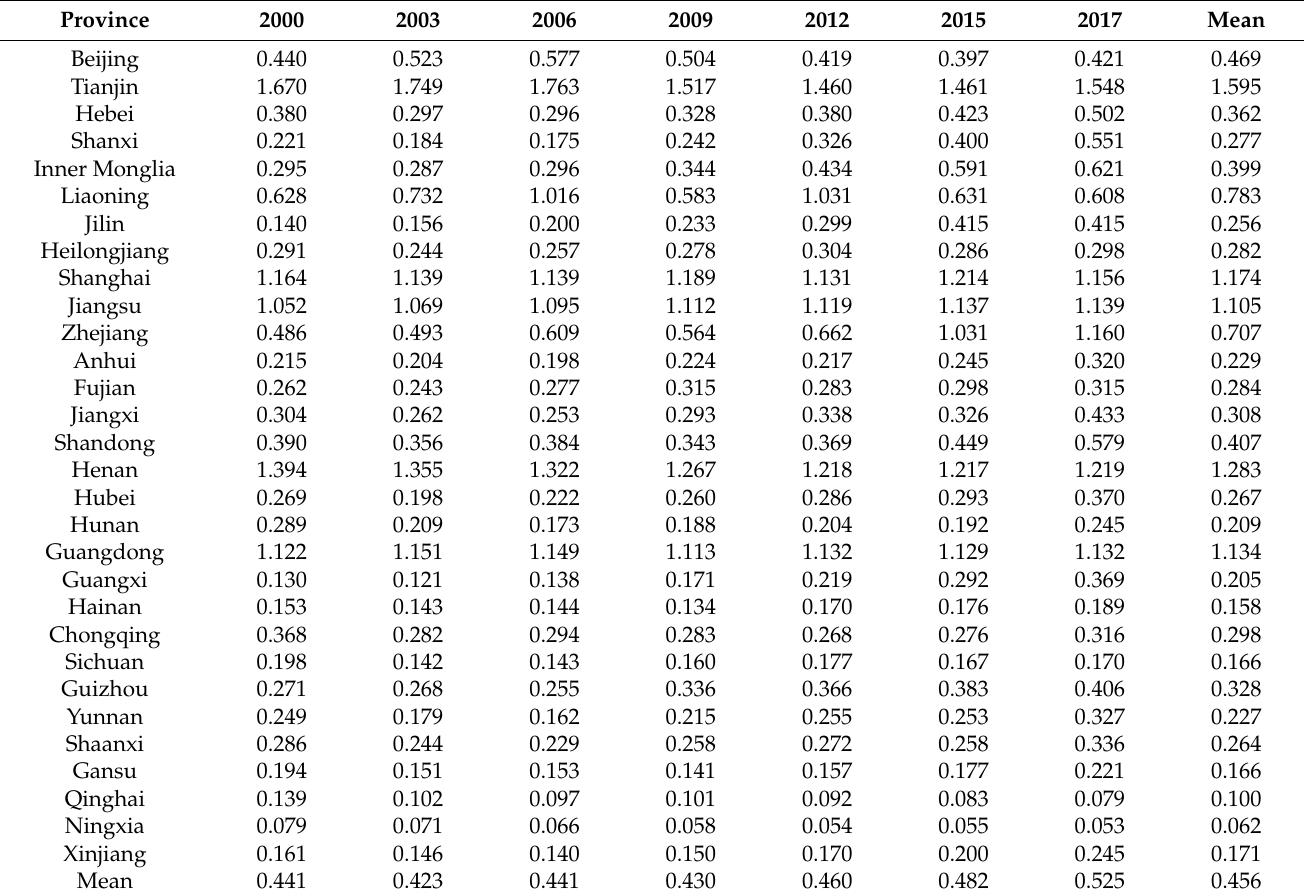
Table 2. Tourism eco-efficiency of 30 provinces from 2000 to